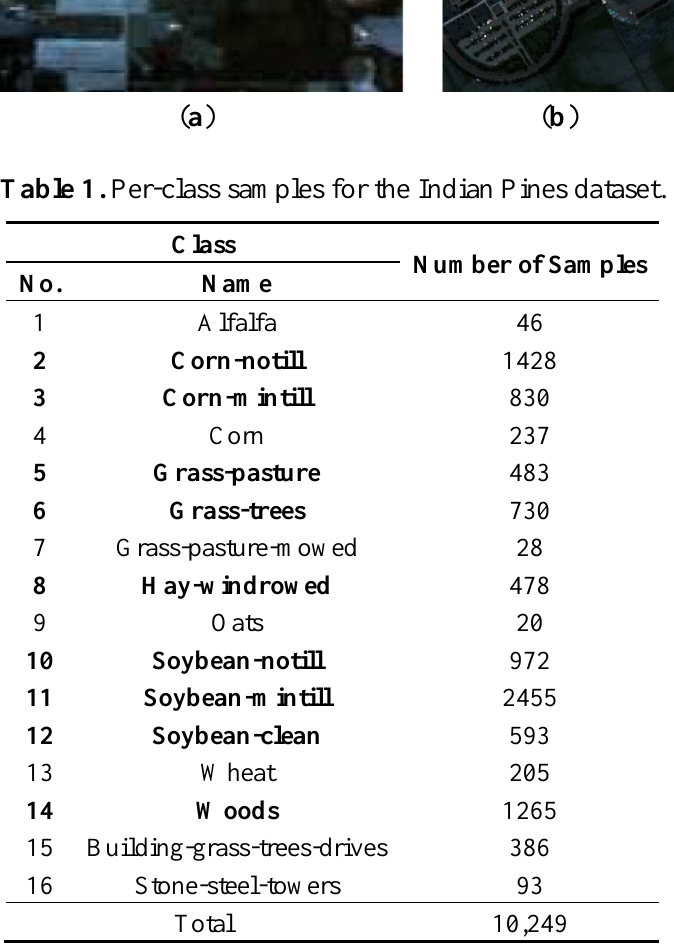
Table 1. Per-class samples for the Indian Pines dataset.